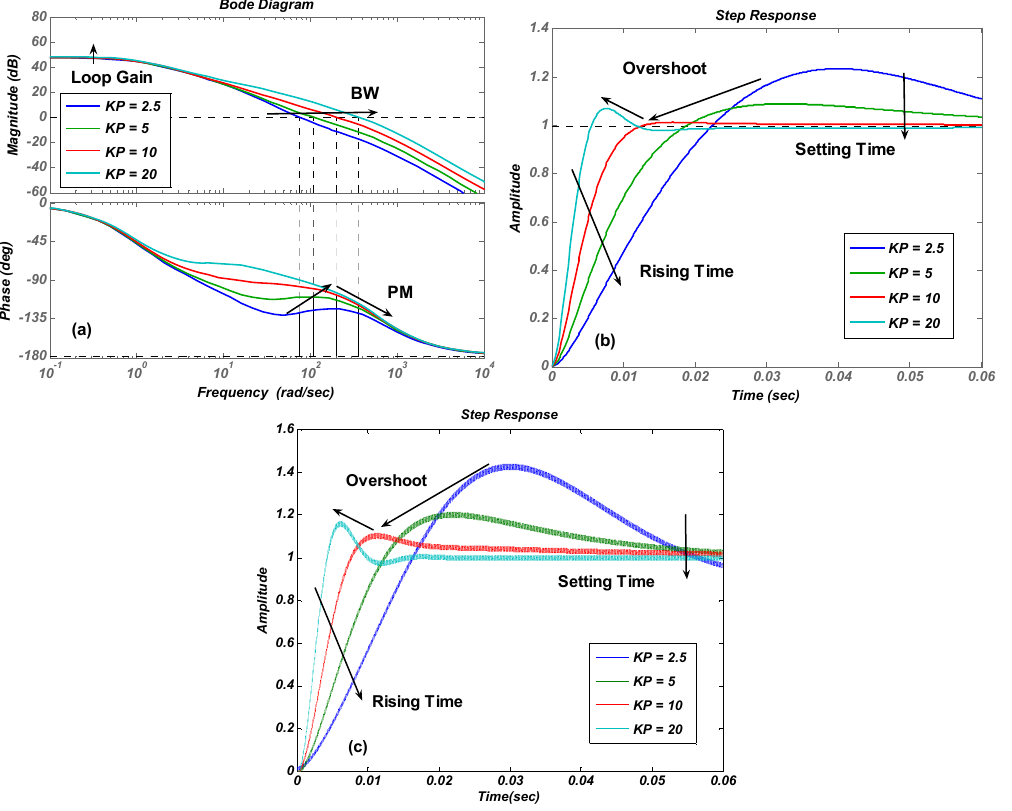
Figure 4. ( a ) Bode diagrams of the control loop ( b ) step responses of the linear model ( c ) and step responses of nonlinear model varying with the proportional term K